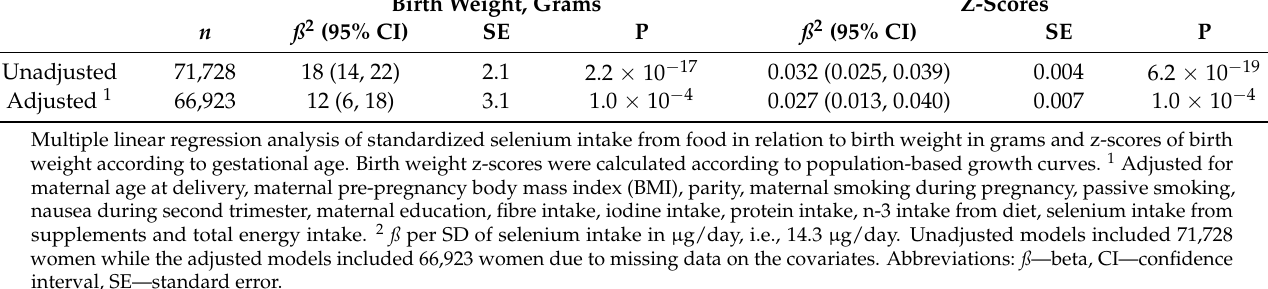
Table 3. Associations between maternal dietary selenium intake and small for gestational age (SGA) birth in 71,728 women from the Norwegian Mother, Father and Child Cohort study.